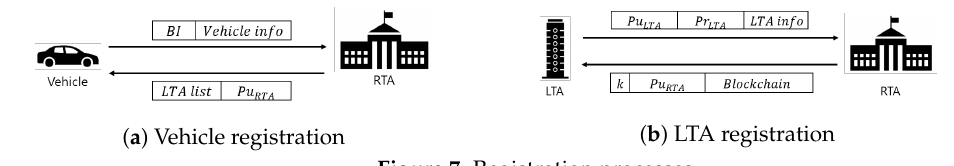
Figure 7. Registration